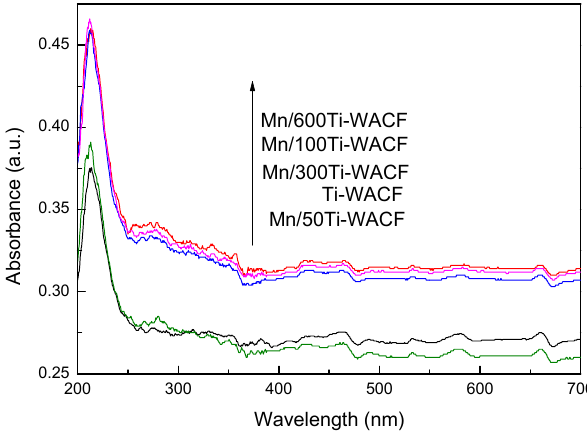
Figure 6. UV–Vis spectra of loaded materials with different Mn doping concentrations.